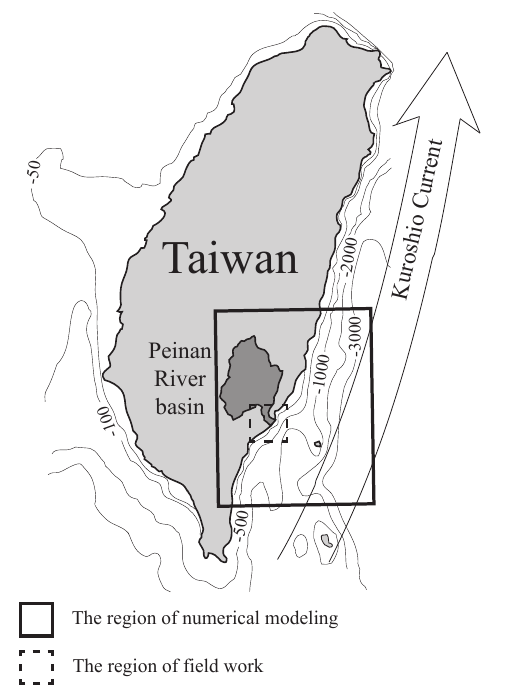
Figure 1. Bathymetry of the Taiwan coastal area and deposition of the study regions at the steep southeastern shore adjacent to the Peinan River estuary.